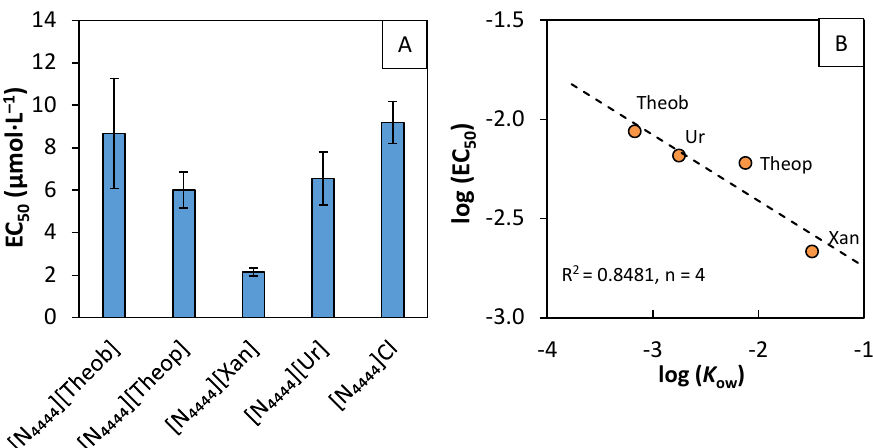
Figure 2. ( A ) EC 50 values ( µ mol · L − 1 ), determined after 96 h of exposure time of Raphidocelis subcapitata to the purine-based salts and [N 4444 ]Cl. The error bars correspond to the 95% confidence interval. ( B ) Correlation between the logarithm of EC 50 and the logarithm of the octanol–water partition coefficient ( K ow ) of the different salt anions [59]. The coefficient of determination ( R 2 ) and the number of experimental points used for the linear regression ( n ) are also presented.